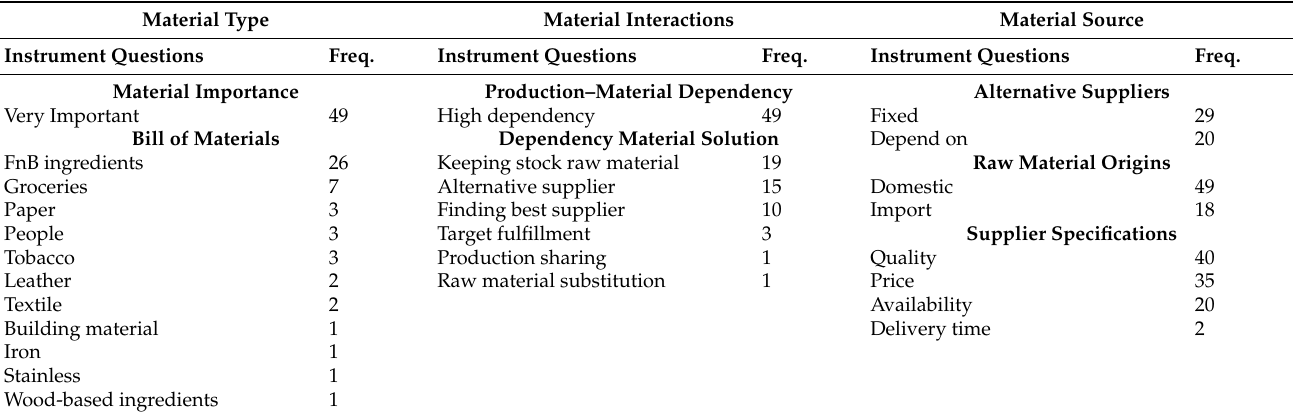
Table 4. The data collected from correspondents are based on material characteristics in the product variety